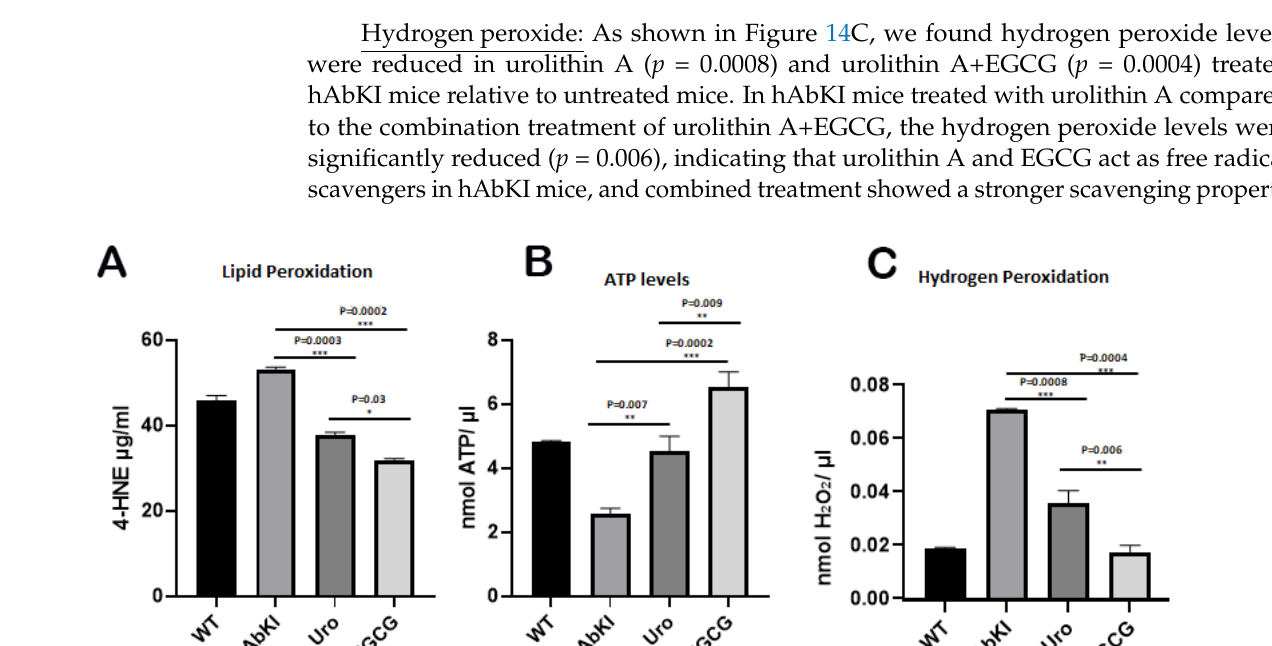
tion) were also significantly reduced in urolithin A ( p = 0.0003) and urolithin A+EGCG ( p = 0.0002) treated hAbKI mice relative to untreated hAbKI mice. In hAbKI mice